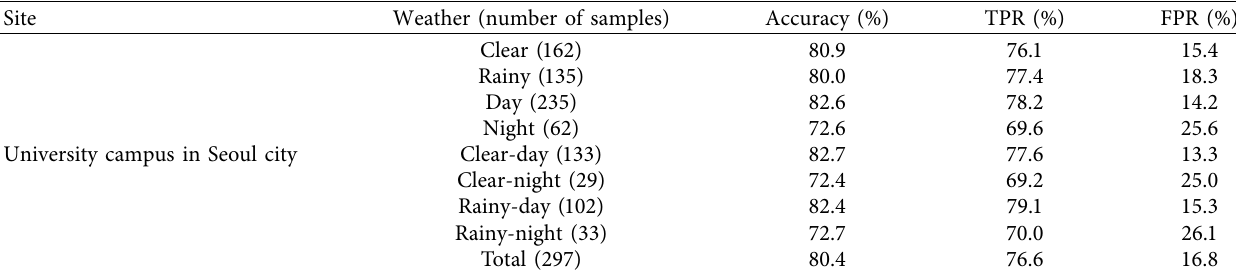
Figure 10: Application site (a campus in Seoul city) under diferent weather conditions: (a) clear weather and (b) rainy weather. Table 2: System verifcation results under diferent weather and lightning